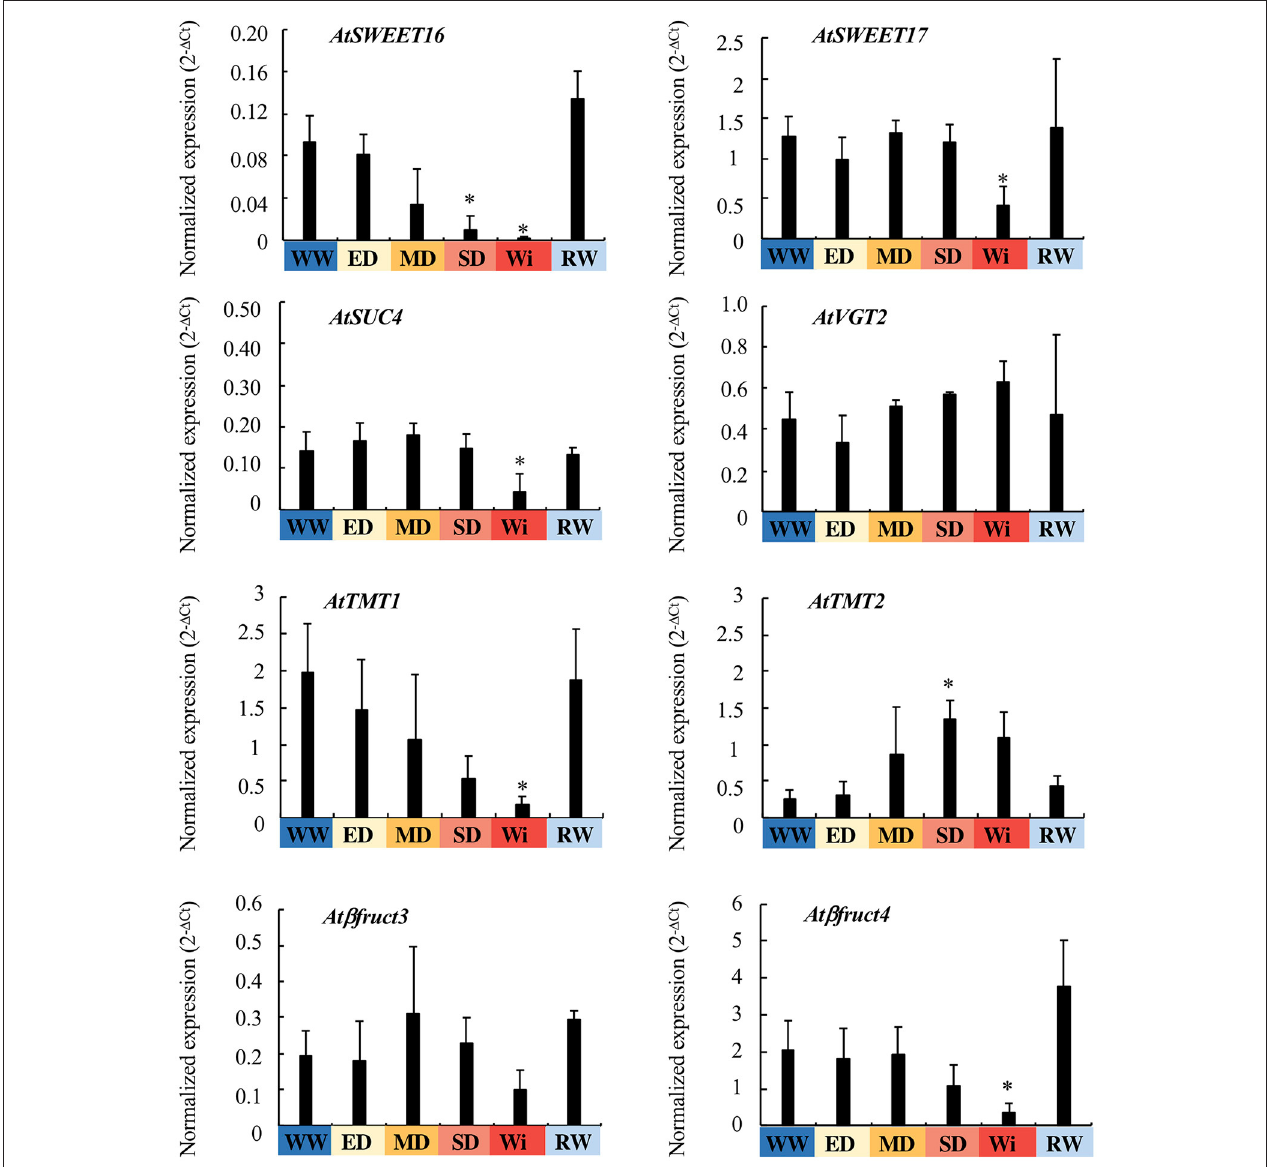
FIGURE 7 | Relative expression of vacuolar sugar transporter (SUT) and invertase genes in the leaves of A. thaliana Col-0, under WW, WD, and RW conditions. The 2 − 1 Ct values are normalized according to AtPP2a expression and are represented as the function of the four phases of water deficit: EM, early mild water deficit; MD, moderate water deficit; SD, severe water deficit; Wi, wilting phase. The value Wi represents the average values of EWi and LWi when these values are not different. The study was carried out with five plants per condition, and two independent biological repeats were performed ( ± SD). The asterisks correspond to significant differences compared to the WW plants, determined by the Mann–Whitney test ( p <